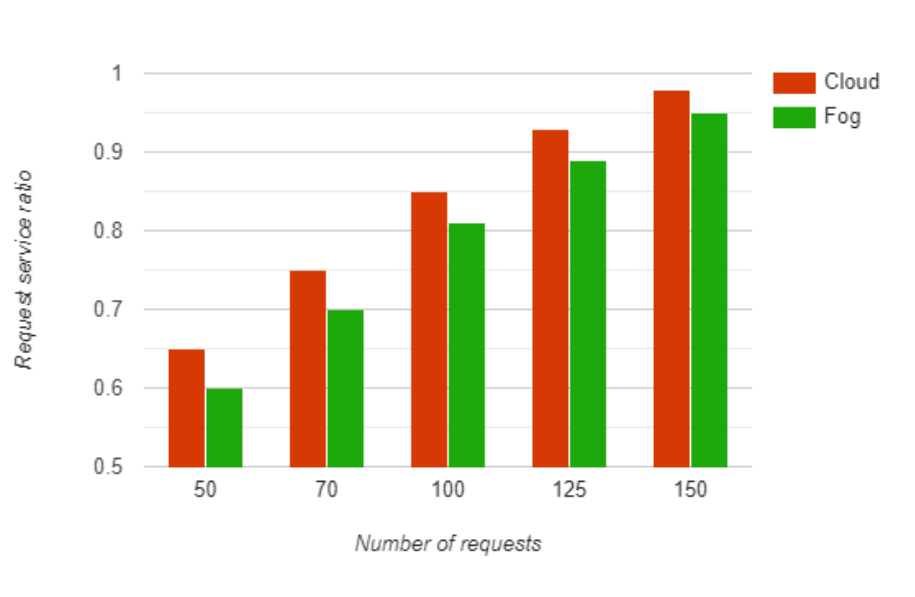
Figure 11. Request service